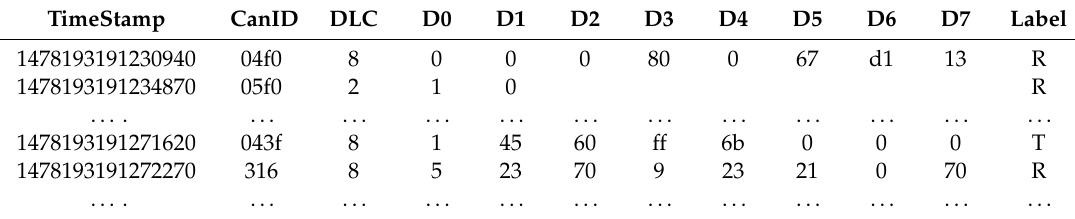
Table 2. Car hacking dataset